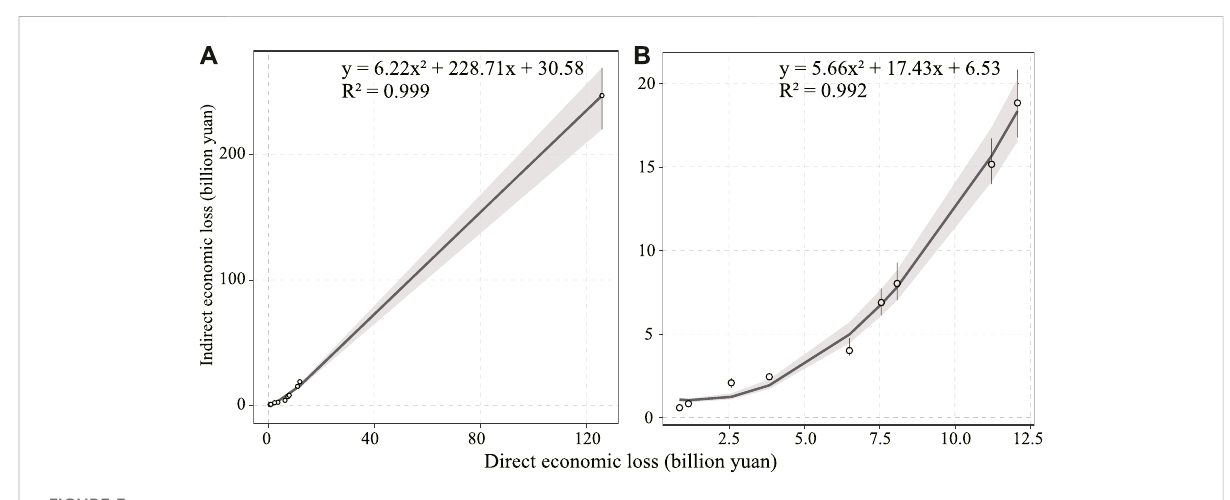
The relationship between DELs and IDELs. (A) The top ten rainstorm events. (B) The remaining nine events excluding Event No.